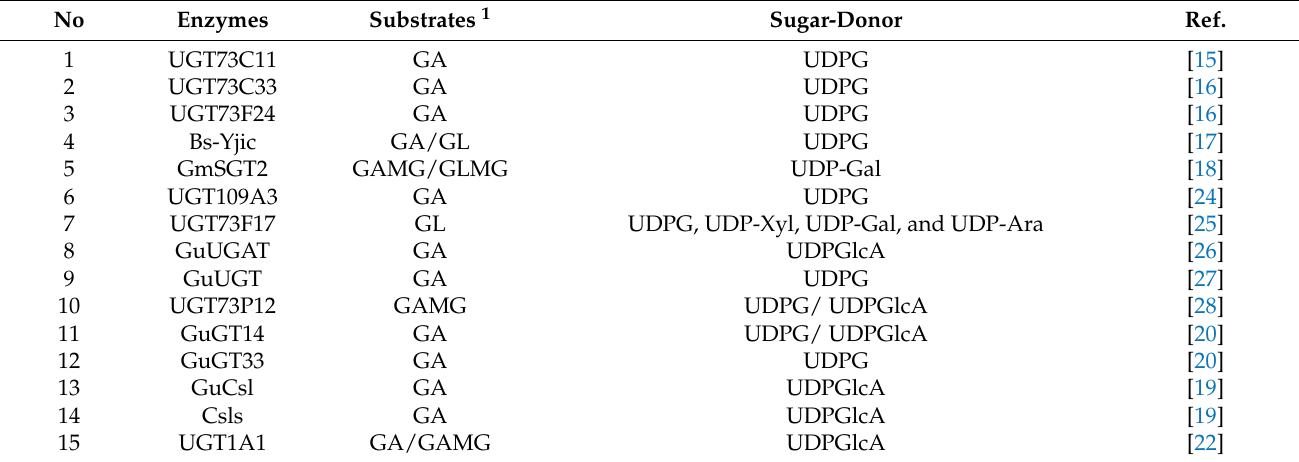
Table 1. Summary of enzymes showing glycosylation activity toward GA and its